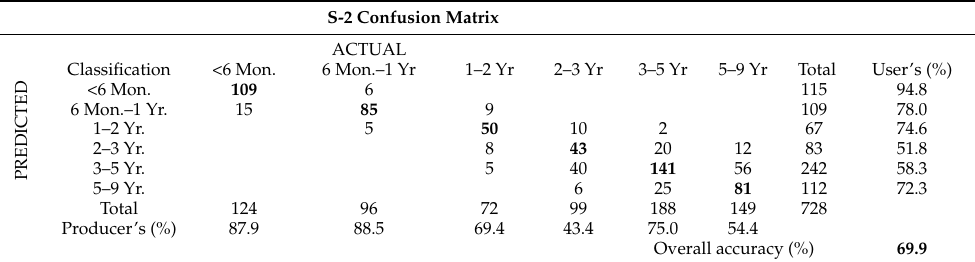
Table 2. Confusion matrix for Sentinel-2 classification of various ages of acacia plantation. Abbrevia- tions: Mon. indicates Months and Yr indicates Year. The bold text denotes correct classifications and the overall